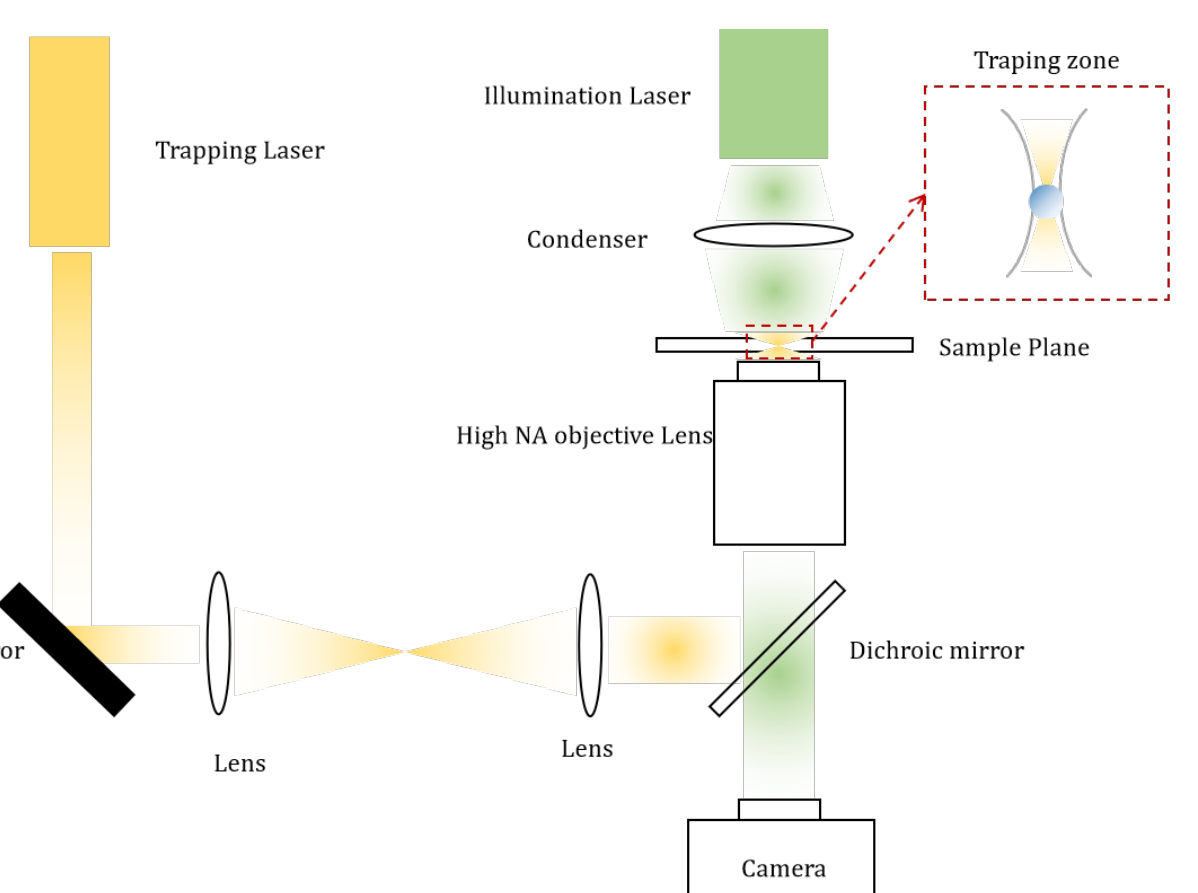
Figure 1. An example of an experimental setup of a traditional optical